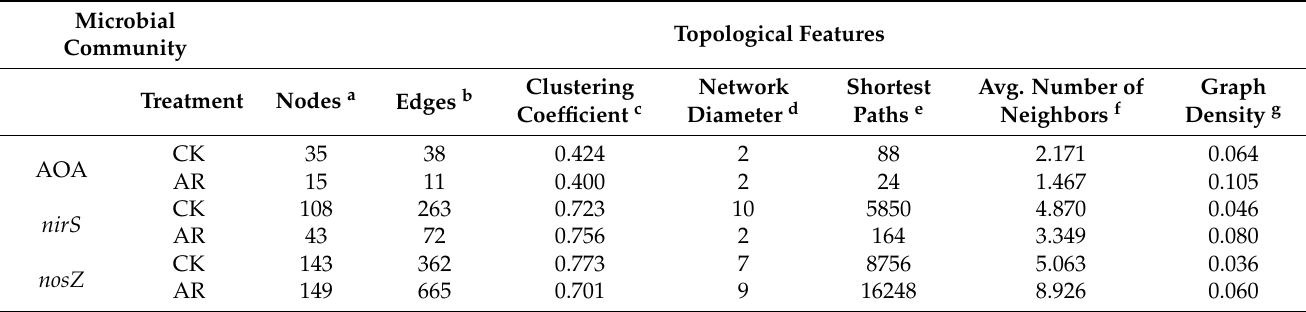
a Operational taxonomical units (OTUs) colored based on genus-level taxonomy; b Number of connections/correlations among nodes; c Denoting the highly interconnected structure of a particular region of a network; d The largest distance between two nodes; e Indicating how quickly the information can be transferred between two nodes; f Indicating the average connectivity of a node; g The ratio of the number of edges to the number of possible maximum edges. AOA: ammonia-oxidizing archaea; nirS and nosZ : nirS- and nosZ -carrying